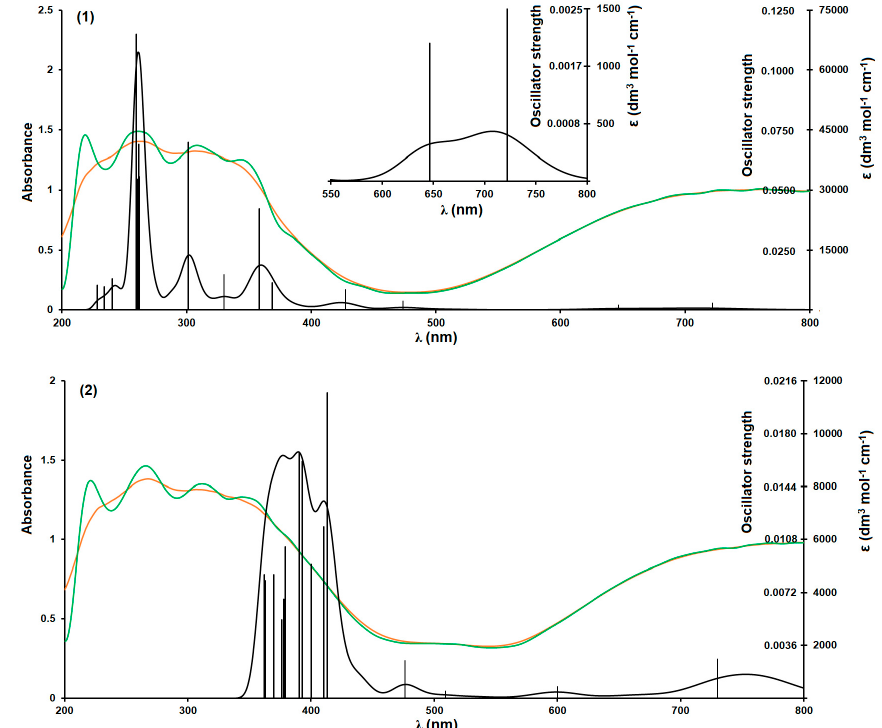
Figure 3. Experimental (orange-registered, green-deconvoluted) and calculated (black) UV-Vis spectra of the studied compounds ( 1 and 2 ). The most important oscillator strengths are shown as vertical black lines.